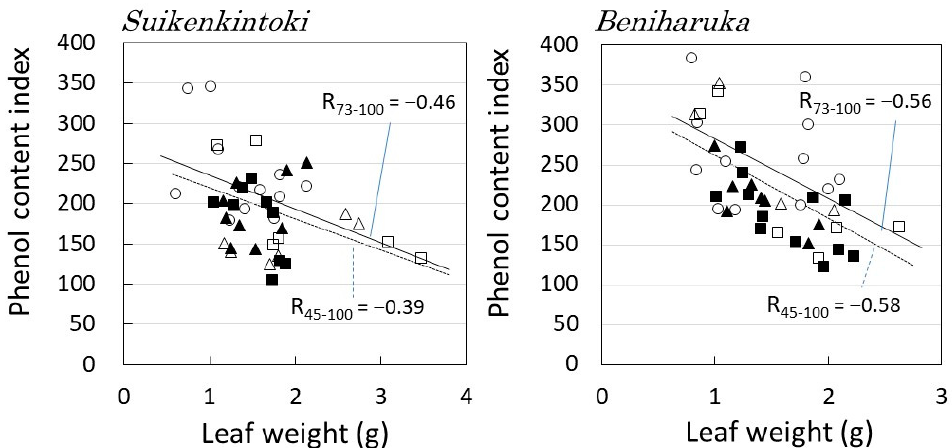
Figure 8. Leaf weight and polyphenol content. Symbols are the same as in Figure 7. The approximate lines were determined by the least-squares method, R 45-100 denotes the correlation coefficient for all data, and R 73-100 denotes the correlation coefficient for data excluding M in and B in . These results suggest that the upper layer with high insolation carries out photosyn-